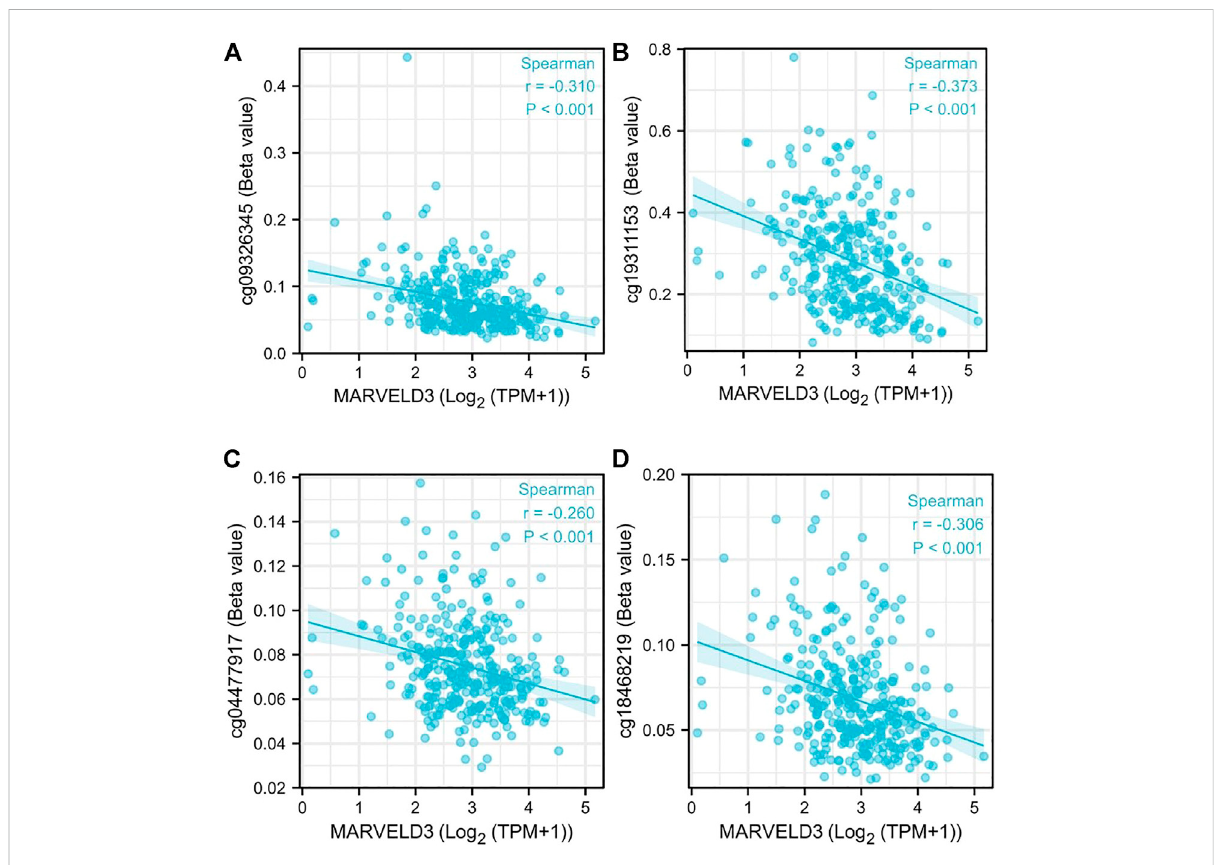
FIGURE 3 MARVELD3 methylation level analysis. (A – D) Correlation of MARVELD3 expression with methylation sites of cg09326345, cg19311153, cg004477917, and